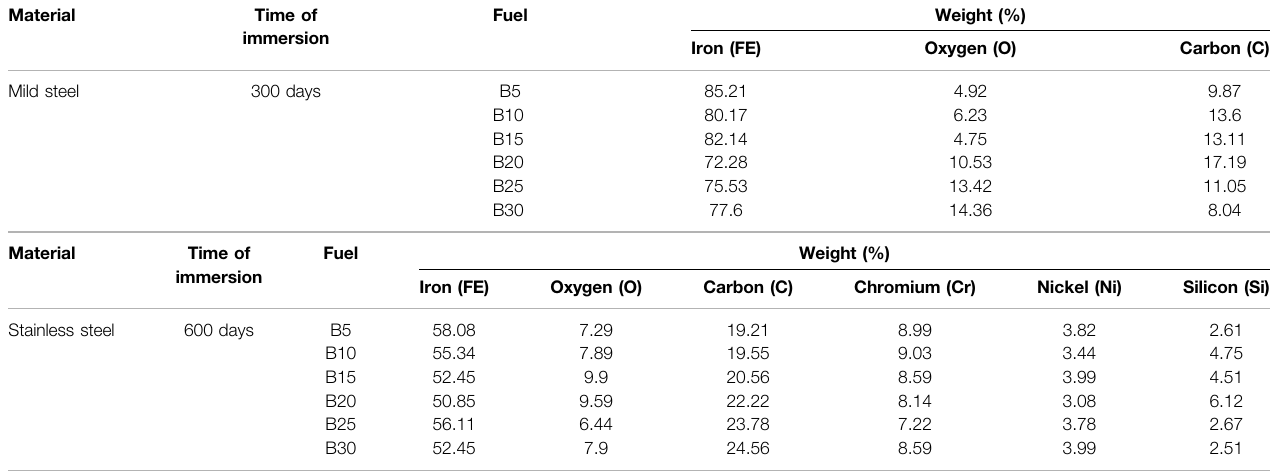
TABLE 5 | Electron-dispersive spectrometer (EDS) for mild steel immersed in B5 – B30 at 300 days and stainless steel immersed in B5 – B30 at 600 days.